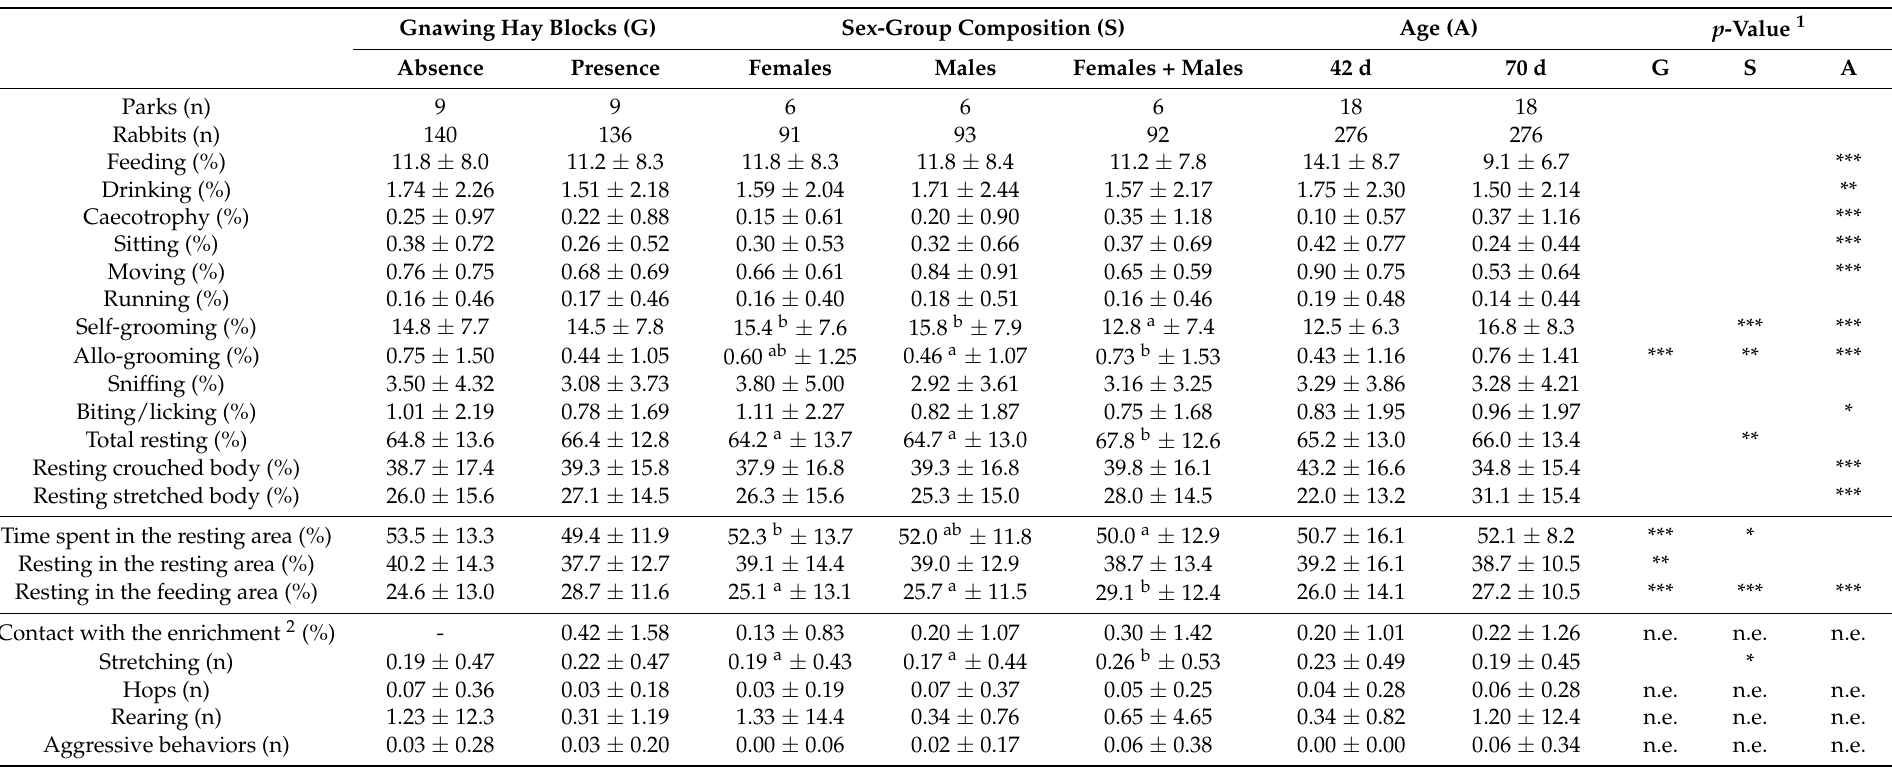
Table 2. Effect of the presence of gnawing hay blocks, sex-group composition, and age on behaviors (% of observation time; number of events per park per observation period) of growing rabbits kept in collective parks across 24 h. Data are reported as means ± standard